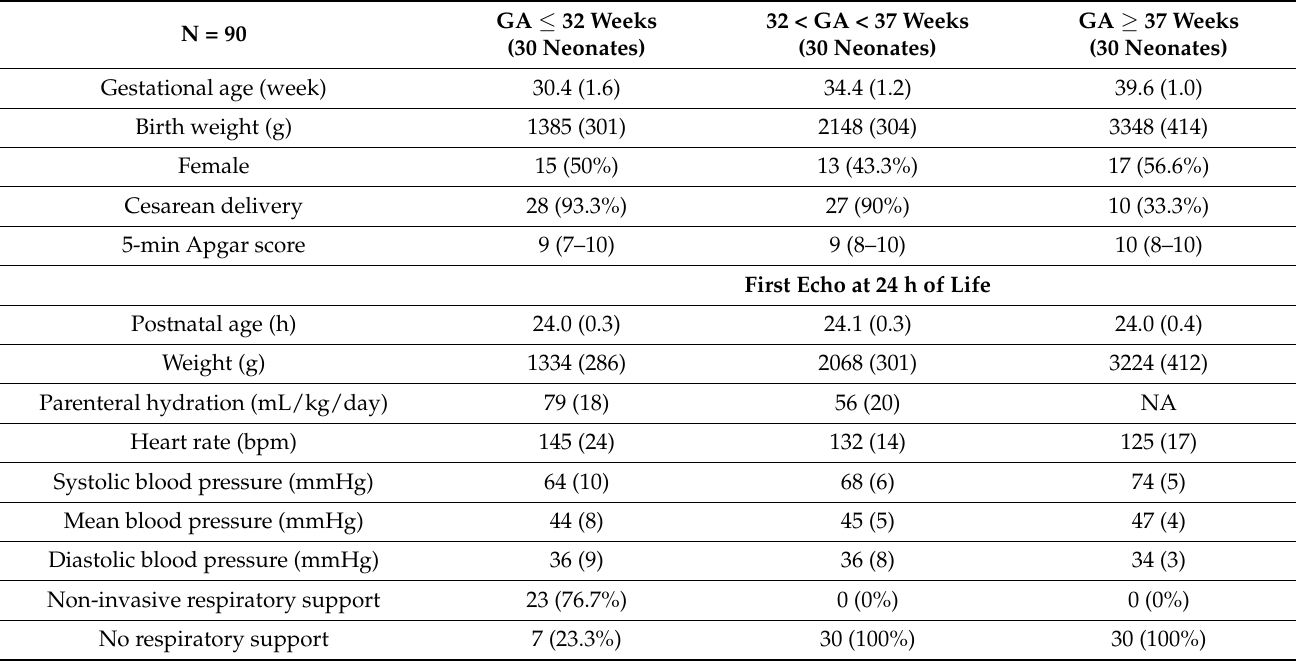
Table 3. Clinical characteristics of the second cohort of